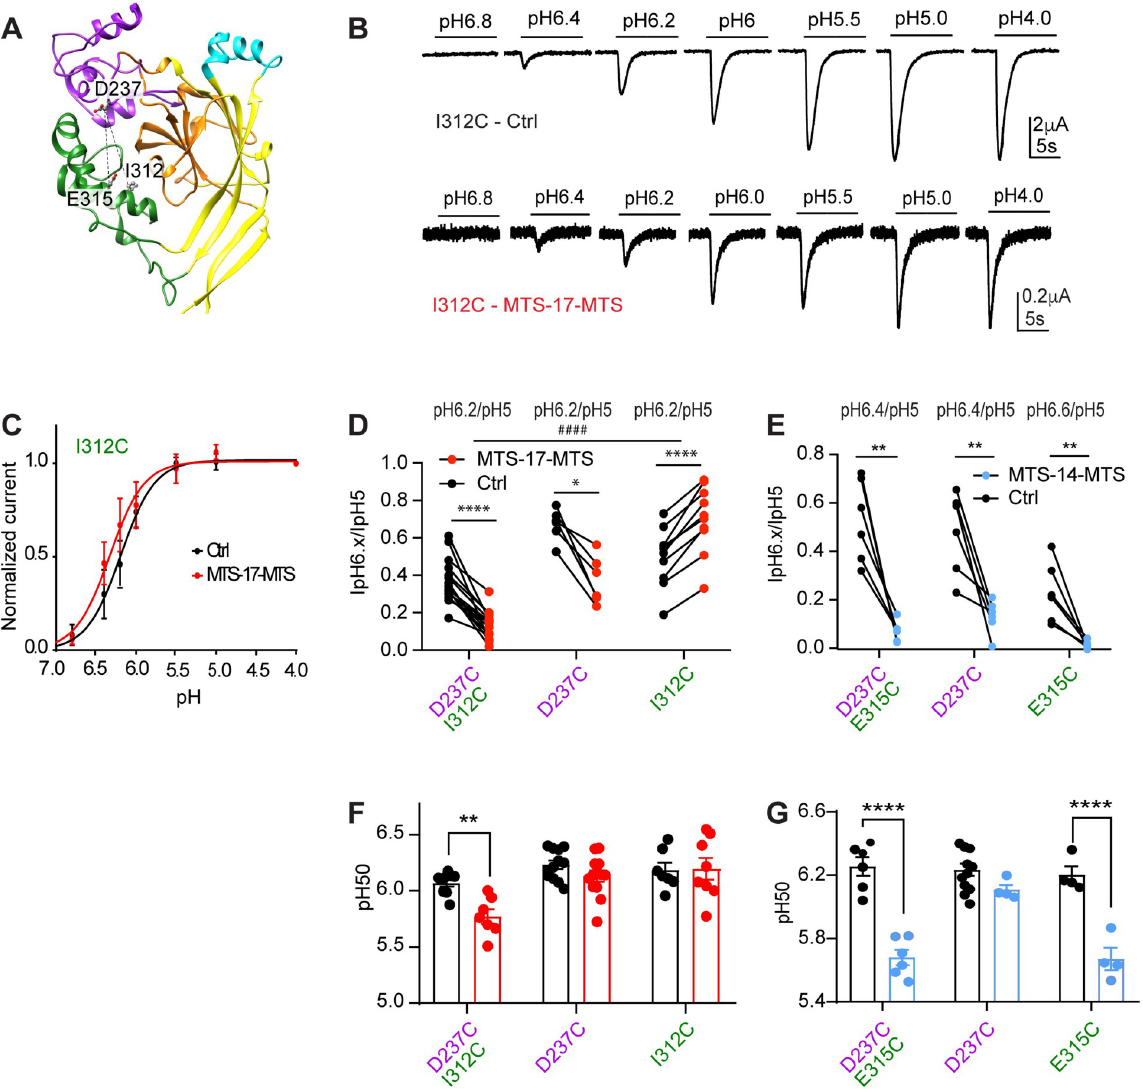
Fig 10. Effect of MTS-cross-linkers on the pH dependence of selected double mutants and corresponding single mutants. Data were obtained from two-electrode voltage-clamp of Xenopus oocytes expressing the indicated constructs, clamped to -60mV. A, Structural representation of hASIC1a model in the closed state, identifying the paired residues of double mutants by the connecting dotted lines. B , Current traces of representative experiments determining the pH dependence of I312C under control conditions (upper panel) and after treatment with MTS-17-MTS (bottom). C, pH-response curves of I312C obtained under control conditions (ctrl, black), and after exposure to MTS-17-MTS (red; n = 12–13). D-G , black symbols refer to control conditions, colored symbols to MTS exposure as indicated. D-E , IpH6.x/ IpH5 ratio under control conditions or after MTS exposure, for double and corresponding single mutants, ( D) , D237C/I312C, ( E ), D237C/ E315C. F-G , pH of half-maximal activation (pH 50 ) values, obtained under control conditions or MTS reagent exposure; significantly different between Ctrl and MTS condition, � , p < 0.05; �� , p < 0.01, ��� , p < 0.001 for D-E (paired t-test) and F-G (unpaired t-test). ####, p < 0.0001; different between single and corresponding double mutant (Ordinary one-way ANOVA, Tukey post hoc test). The color of the mutant label matches that of the domain in which the mutation is